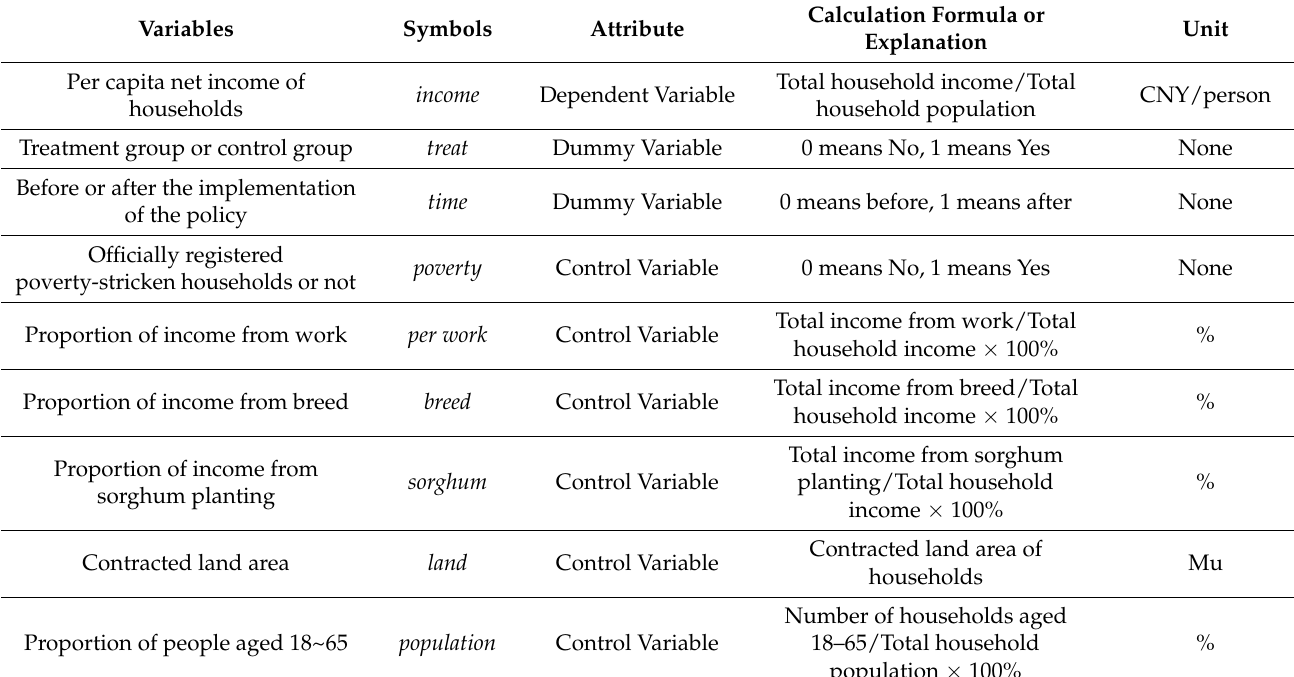
Table 4. Selection of Variables of Household Survey in 2016 and